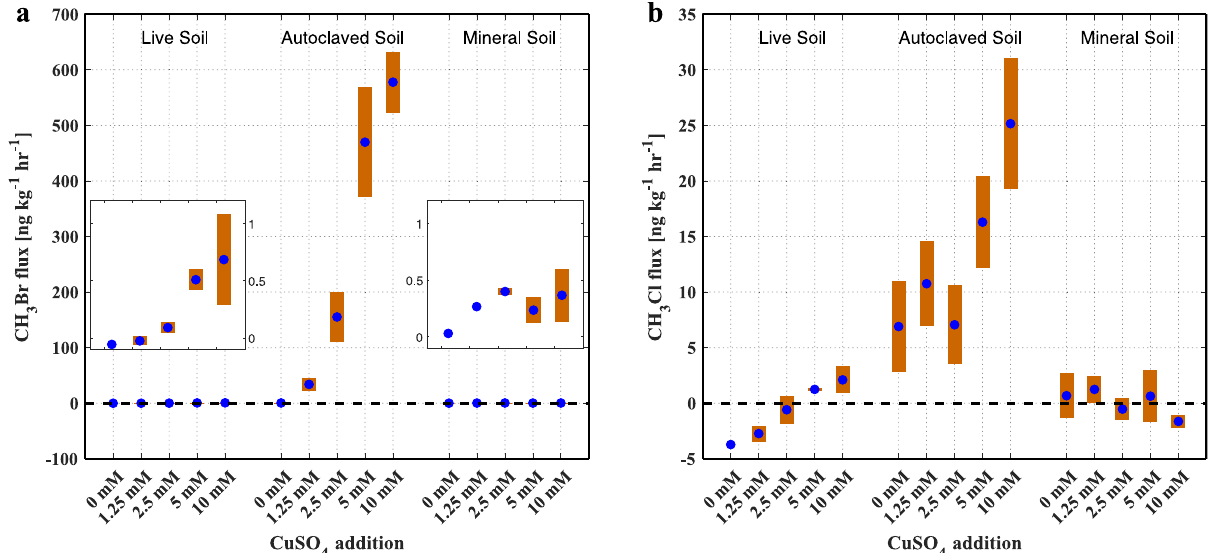
Fig. 1 Methyl halide fl uxes from soil samples amended with different amount of CuSO 4 . a Methyl bromide (CH 3 Br) and b methyl chloride (CH 3 Cl) fl uxes from live, autoclaved, and mineral soil samples mixed with 10 ml of different concentrations of CuSO 4 solution. The blue dots represent the average fl uxes of two replicate incubations ( n = 2) and the upper and lower boundary of the bars represent the two individual fl uxes. The inserted plots in ( a ) are the enlarged view of CH 3 Br fl uxes from live and mineral soils.